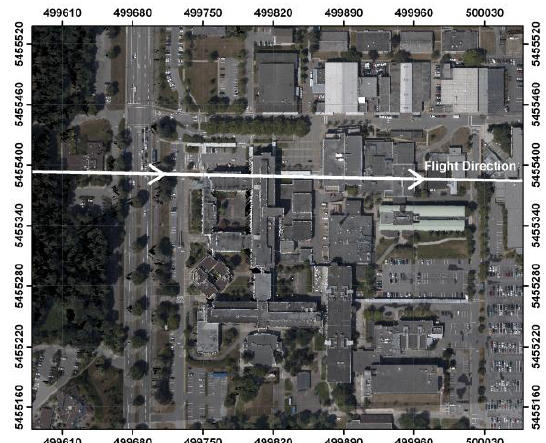
Figure 4. The study area at British Columbia Institute